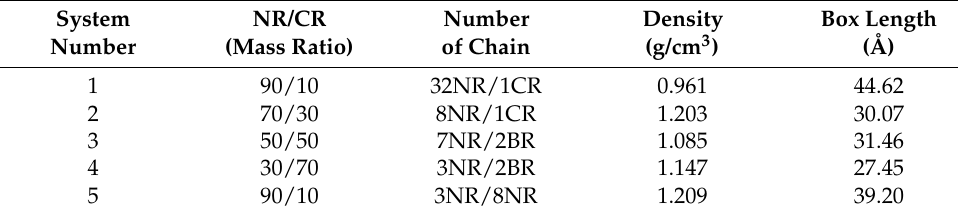
Figure 1. Modeling process of the NR/CR blends. (White corresponds to hydrogen atoms, gray corresponds to carbon atoms, and light green corresponds to chlorine atoms. A, B, and C mean the end-point positions of the modeling box along the x , y , and z axis, respectively.) Table 1. Initial model-building parameters of the NR/BR blends.